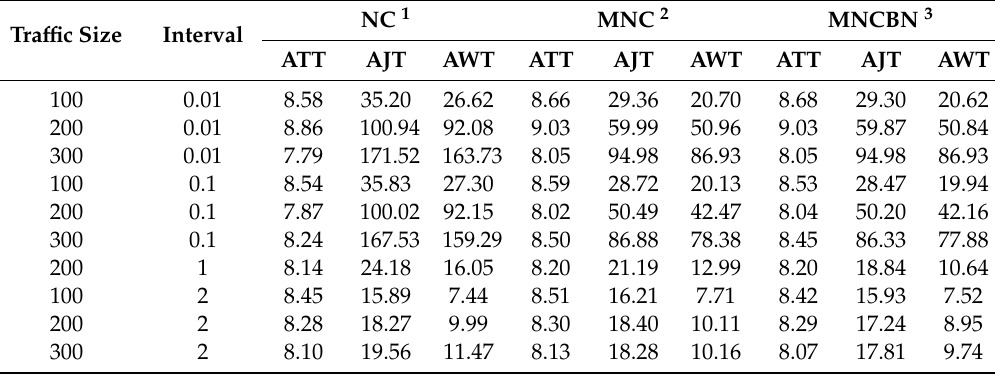
Table 1. Simulation results for the uppeak tra ffi c